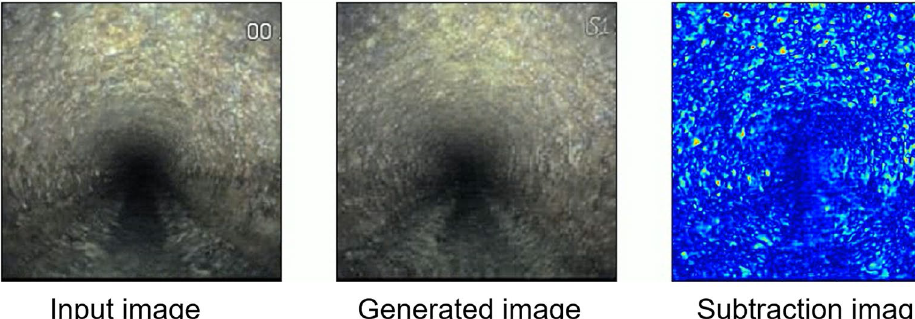
Fig. 9 Experimental results of normal cast iron pipe (GAN)